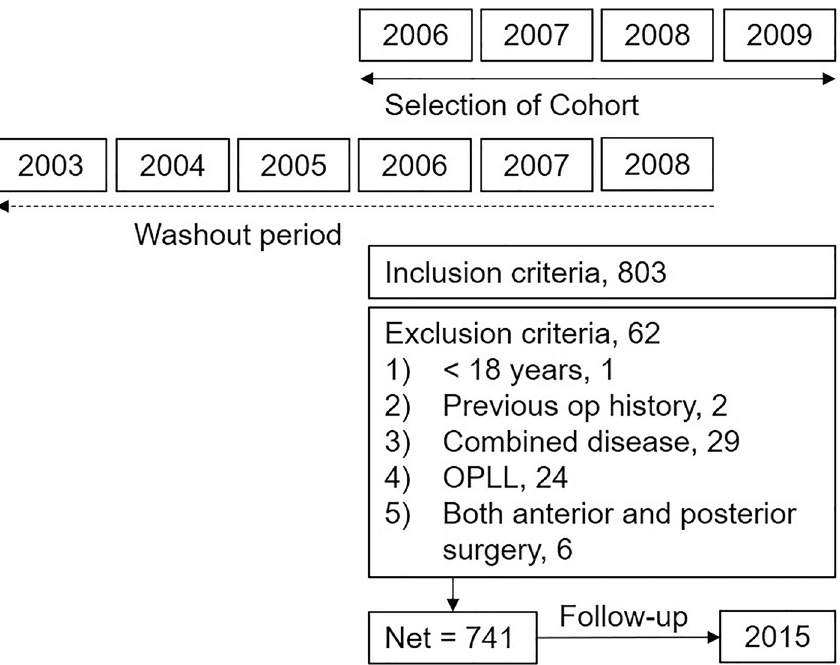
Figure 1. Flow diagram of the included patients. Patients were selected from 2006 to 2009, and the washout period was 3 years for each year of selection. Finally, 741 patients were selected and followed-up until